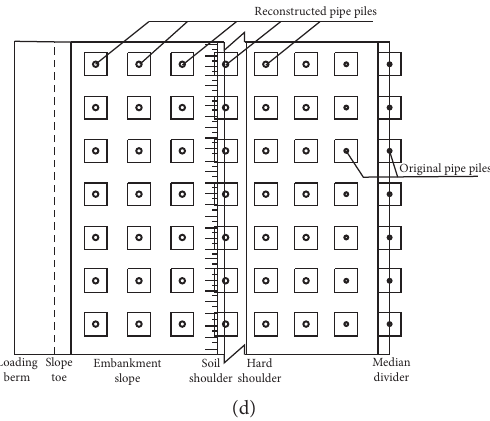
Figure 12: Cross sections and plans of reinforcement measures in two sections. (a) Cross section of the cracking section. (b) Cross section of the sliding section. (c) Plan of the cracking section (half embankment). (d) Plan of the sliding section (half